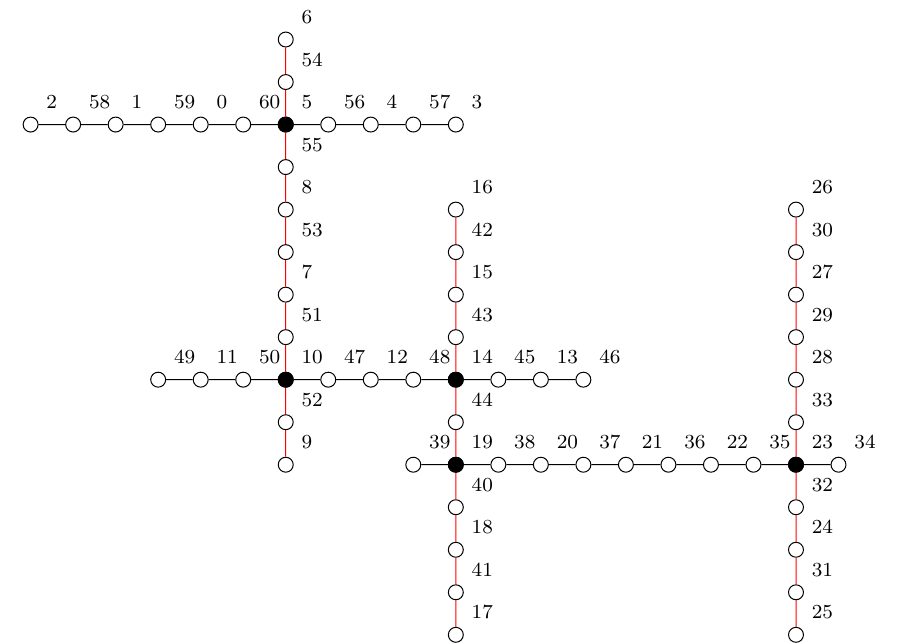
Figure 3: α -labeling of a chain of paths